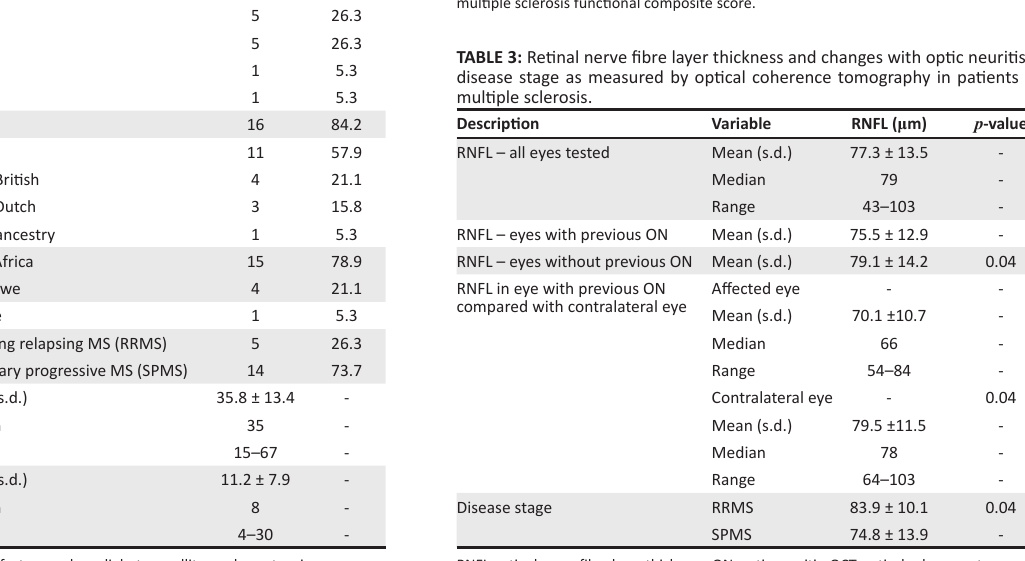
RNFL, retinal nerve fibre layer thickness; ON, optic neuritis; OCT, optical coherence